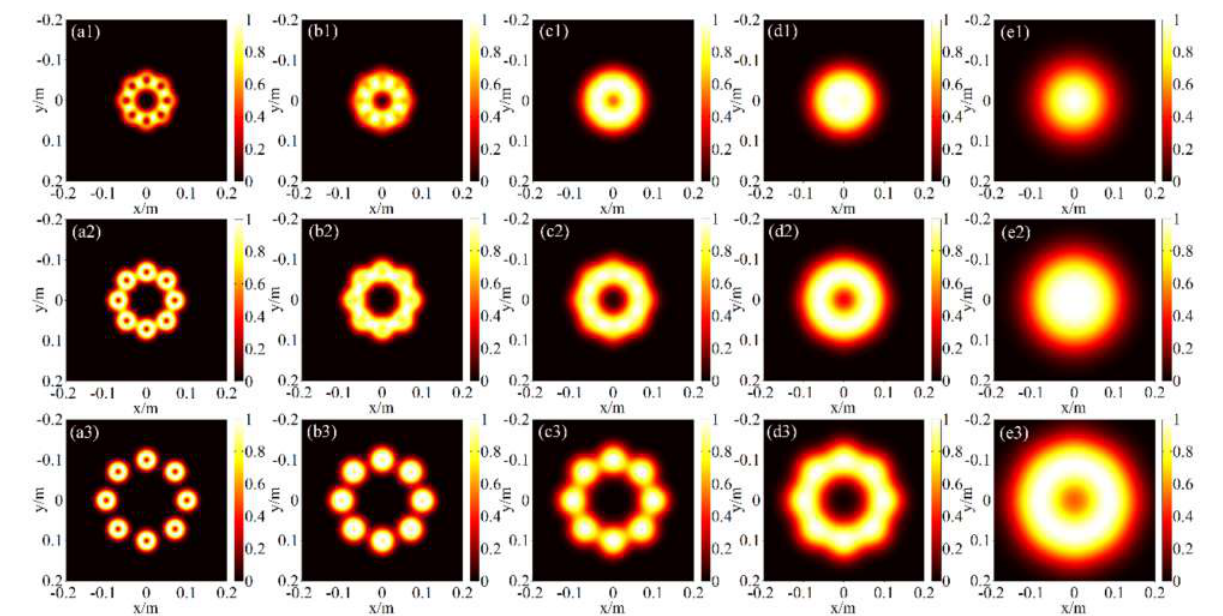
Figure 2. Intensity distributions of the RPLPCV beam array with different radial radii ( a1 – e1 ) r n = 5 w 0 , ( a2 – e2 ) r n = 7 w 0 and ( a3 – e3 ) r n = 10 w 0 propagated through non-Kolmogorov turbulence for different propagation distances: ( a1 – a3 ) z = 0.5 km; ( b1 – b3 ) z = 1 km; ( c1 – c3 ) z = 1.5 km; ( d1 – d3 ) z = 2 km; ( e1 – e3 ) z = 3 km.